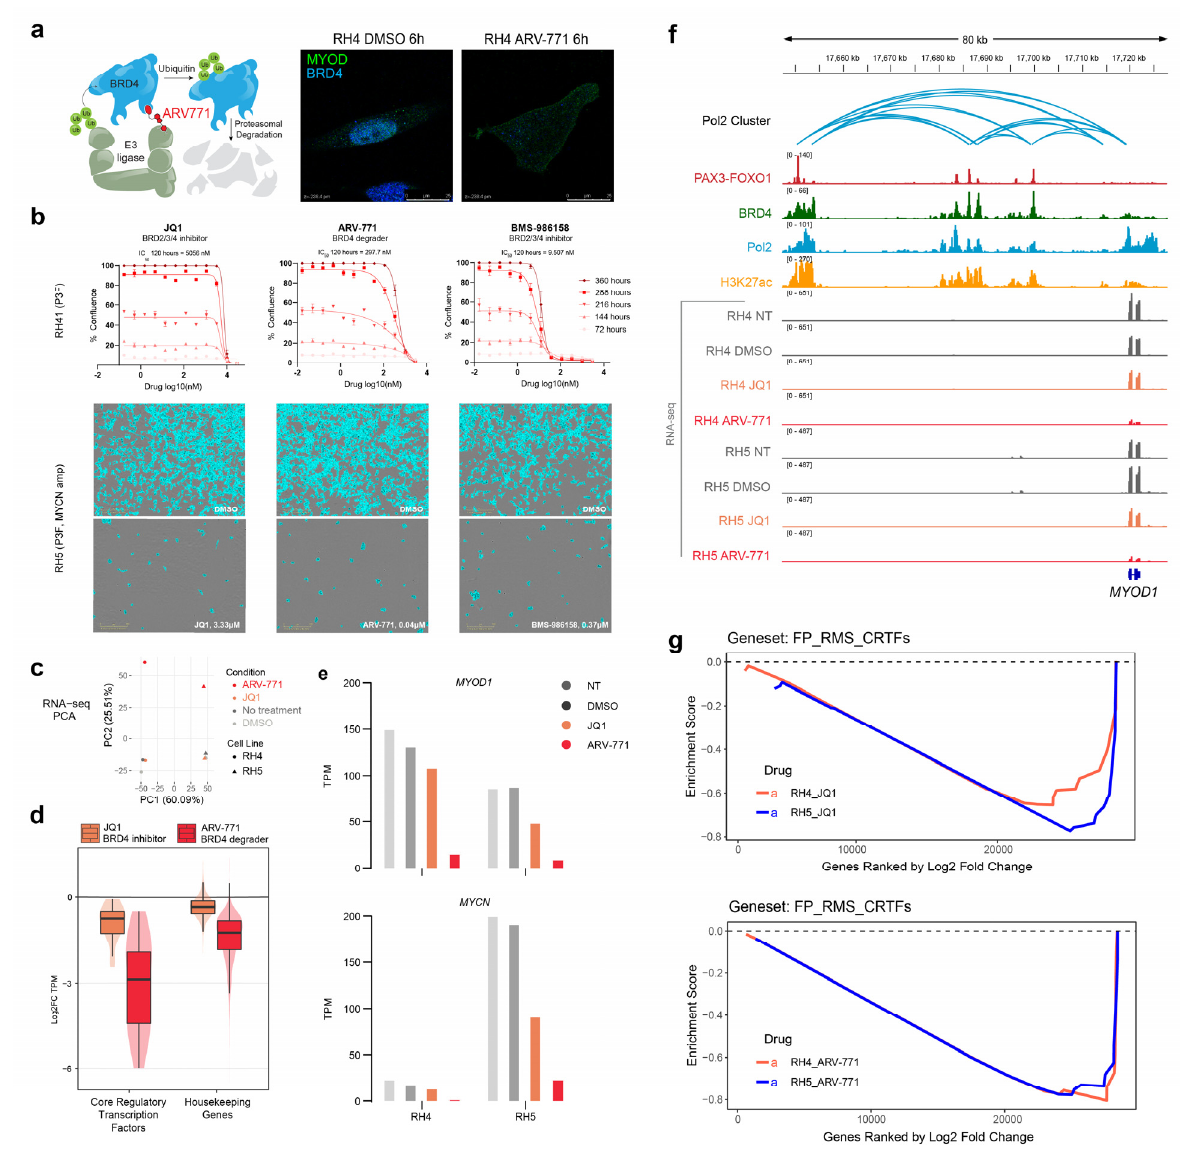
Figure 1. Decrease in cell proliferation and global transcription upon BET bromodomain inhibition and degradation. ( a ) E3-ligase-dependent proteasomal degradation of BRD4 achieved by PROTAC ARV-771 (left), and immuno fl uorescence of MYOD (green) and BRD4 (blue) in RH4 cells after 6 h of treatment with ARV-771 showing near-complete removal of BRD4 from the cell nucleus. ( b ) Cell proliferation assay of RH41 (P3F+) over 120 h. The BRD4 inhibitor JQ1 has an IC 50 of 5056 nM; the BRD4 degrader ARV-771 has an IC 50 297.7 nM; the BRD4 inhibitor BMS-986165 has an IC 50 of 9.5 nM. Below are representative images of the e ff ect of BRD4 inhibition or degradation on cell con fl uence.